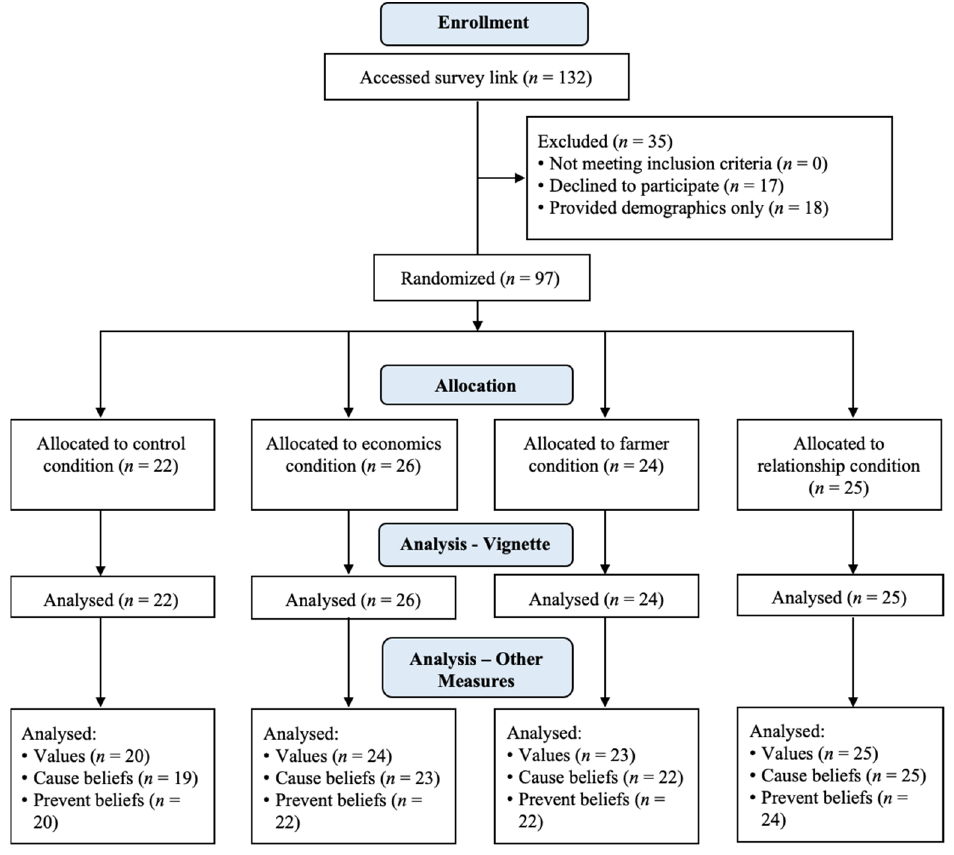
Figure 3. CONSORT (Consolidated Standards of Reporting Trials) diagram showing flow of participants through study.